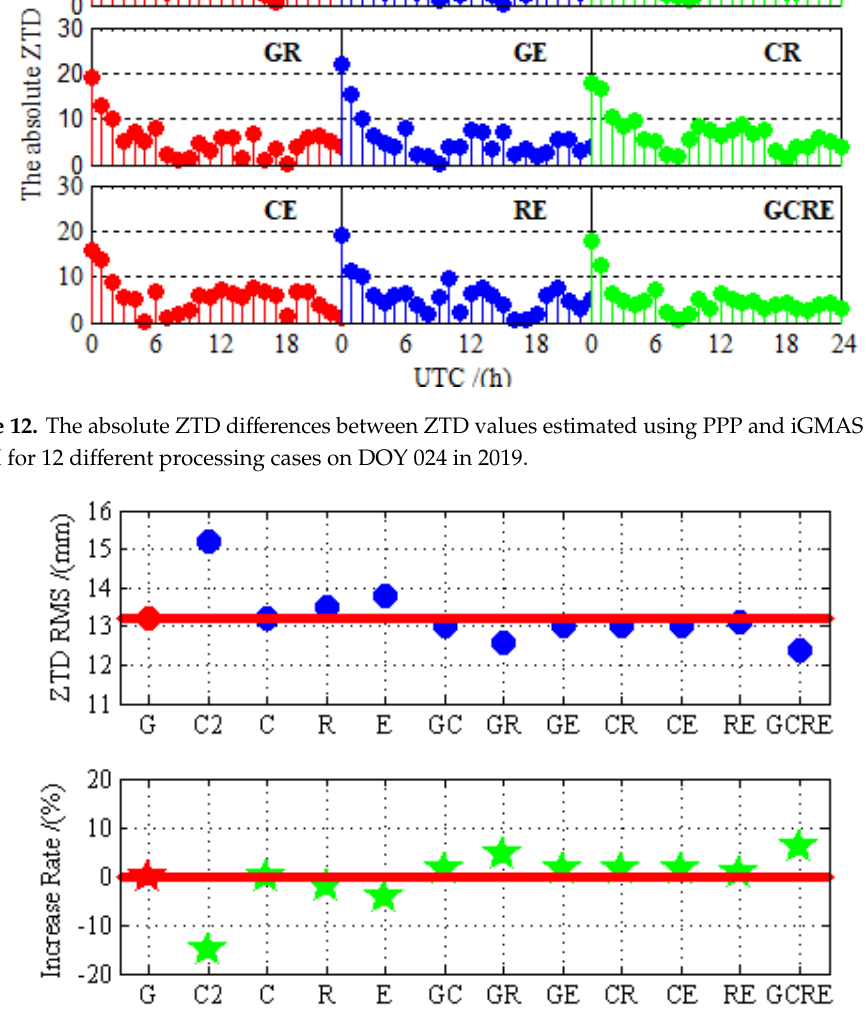
Figure 13. The RMS error of ZTD and the increase rate based on GPS-only results for GPS-only, BDS- 2-only, BDS-2/BDS-3, GLONASS-only, Galileo-only, GPS/BDS-2/BDS-3, GPS/GLONASS, GPS/Galileo, BDS-2/BDS-3/GLONASS, BDS-2/BDS-3/Galileo, GLONASS/Galileo, and GPS/BDS- 2/BDS-3/GLONASS/Galileo static PPP processing using real observation data collected at 16 stations over 30 days.